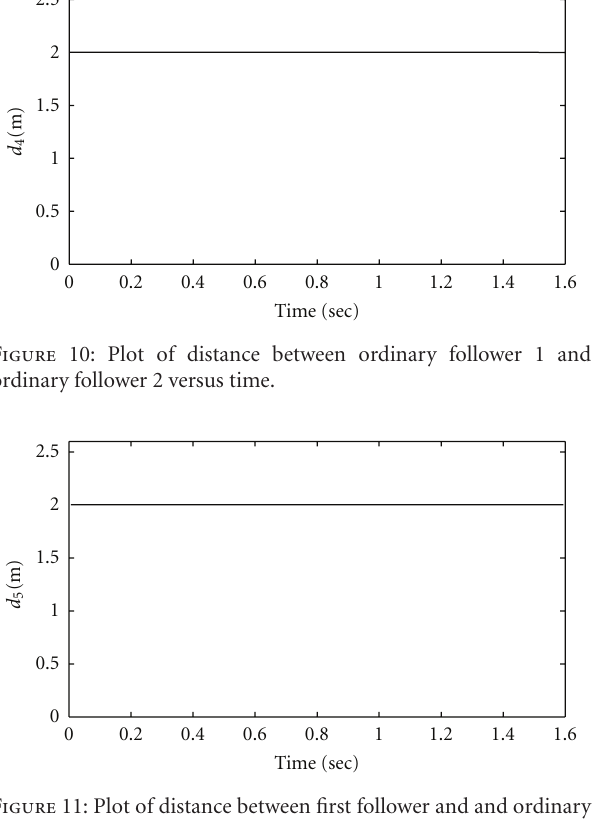
Figure 11: Plot of distance between first follower and and ordinary follower 2 versus time.